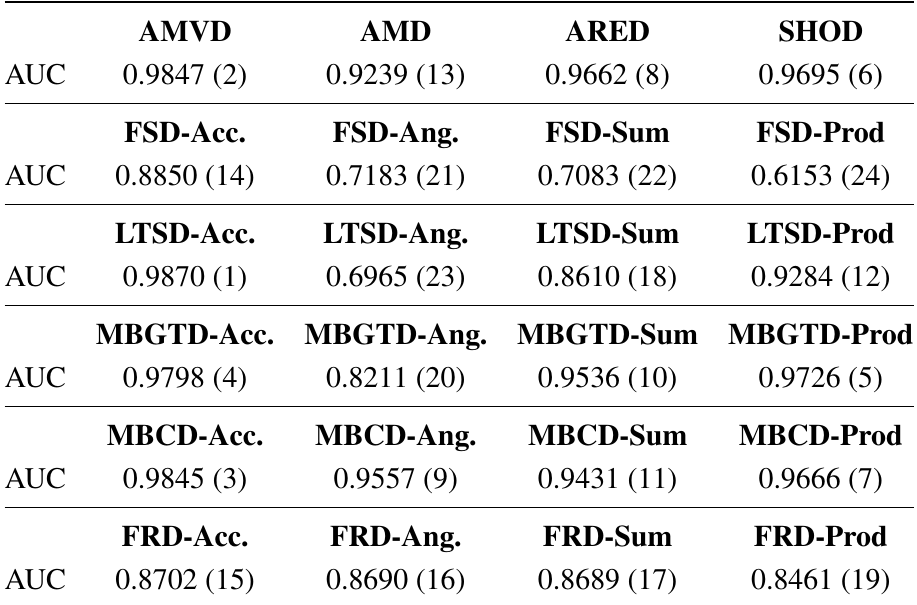
Table 14. Area Under Curve (AUC) computed out of ROC curves obtained from application of algorithms on real signals. Number in brackets indicates overall position in performance